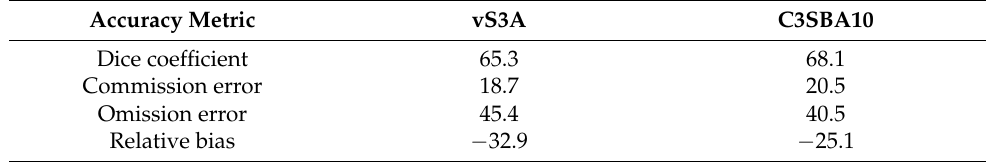
Table A3. Accuracy metrics for 2019 of the 13 calibration tiles. C3SBA10 is the official C3S BA product, which used both S3A and B images. Conversely, vS3A represents the version that uses only